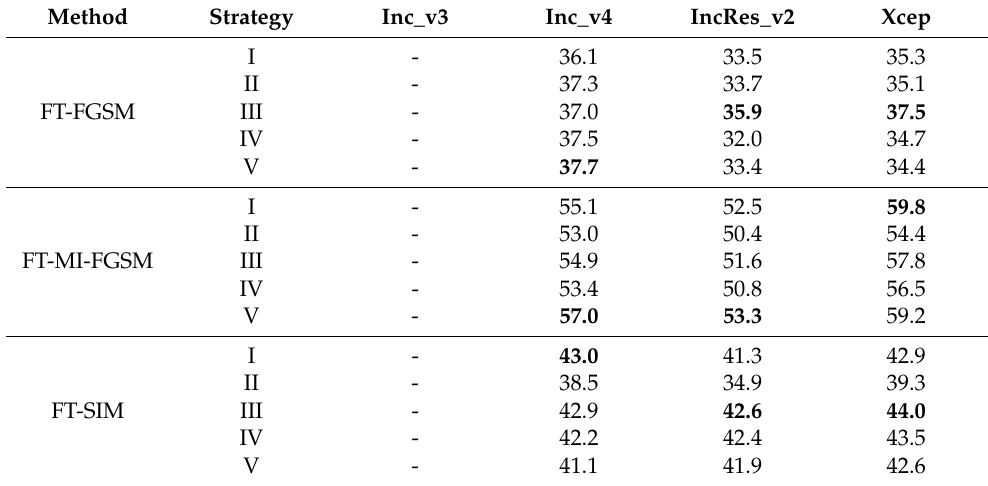
Table 1. The black-box ASRs (%) of FT-FGSM, FT-MI-FGSM, and FT-SIM with five strategies on ImageNet. The adversarial examples are generated on Inc_v3. The highest ASRs are shown in